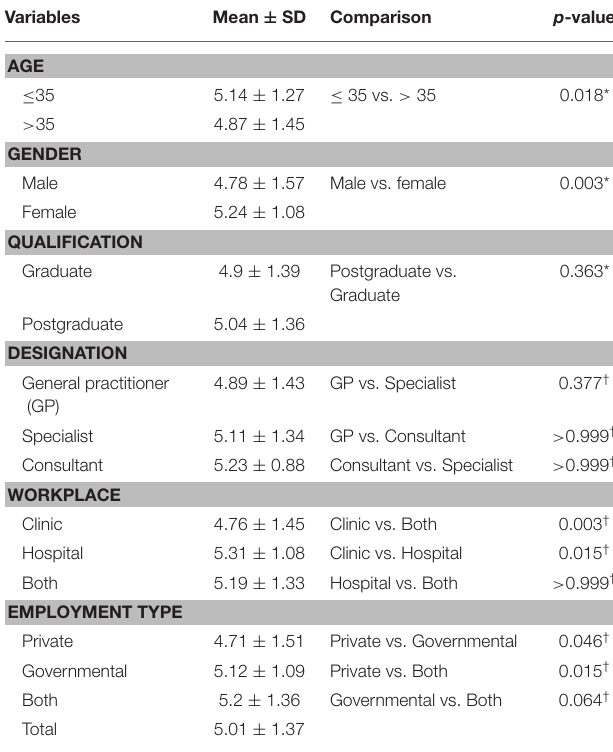
TABLE 3 | Respondents’ anxiety of the COVID-19